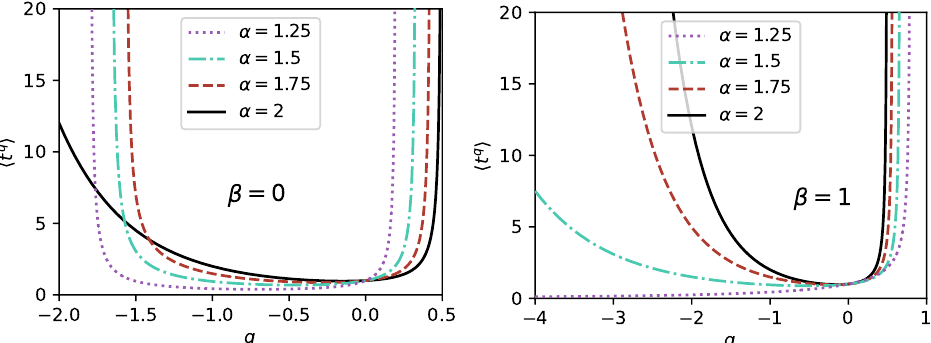
Figure 3. Fractional-order moments of the first-arrival density of Lévy flights for x 0 = 1 and K α =